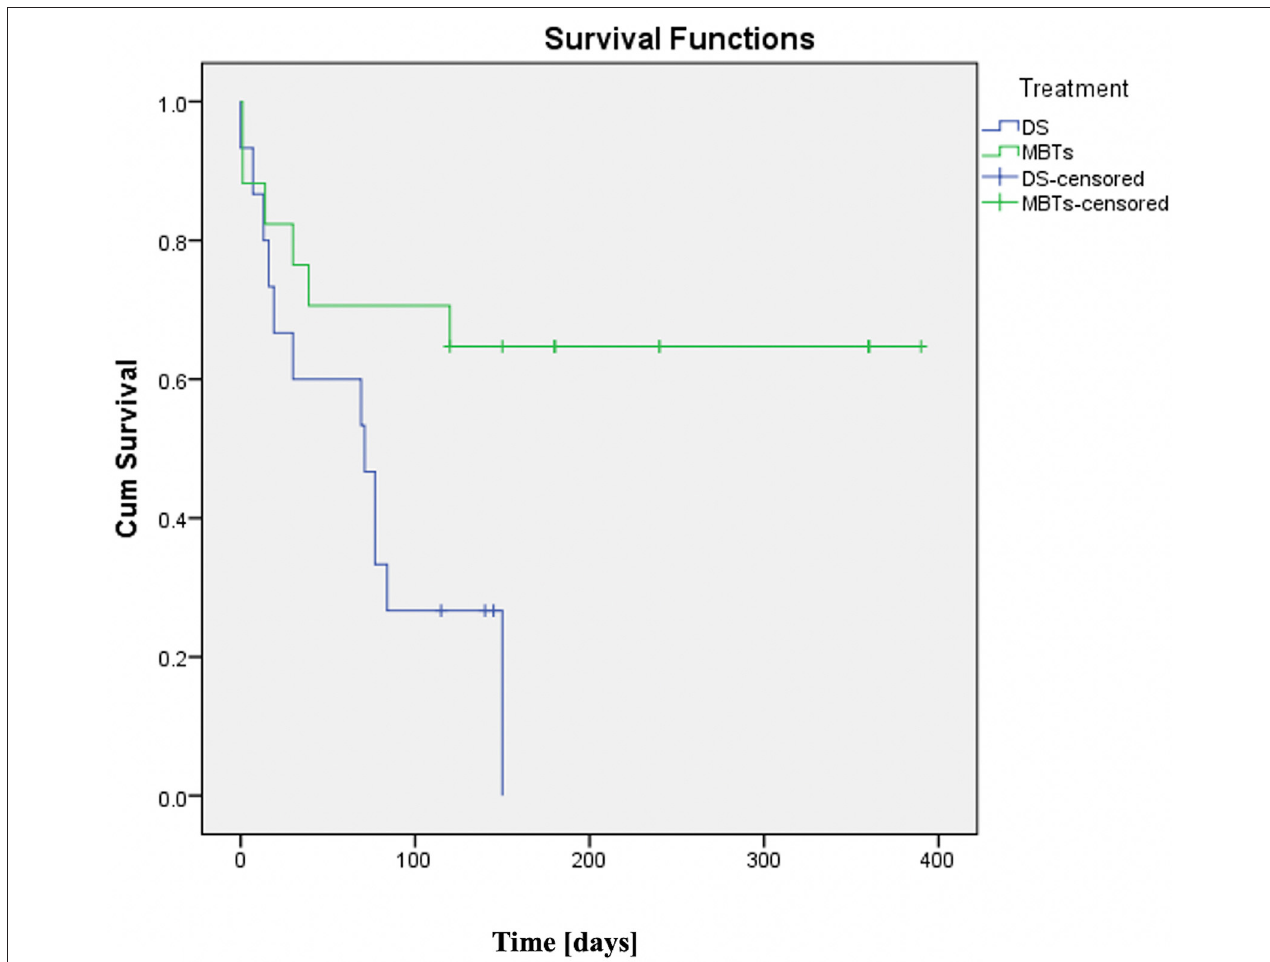
FIGURE 2 | Kaplan–Meier curve (DS vs. MBTs in ducts with ductal curvature index (DCI) > 0.45). Compared with DS-group with DCI > 0.45 which showed very low survival, patients with a DCI > 0.45 underwent MBTs and had much better survival rates with the majority reaching their next planned surgery. Time since procedures is indicated in